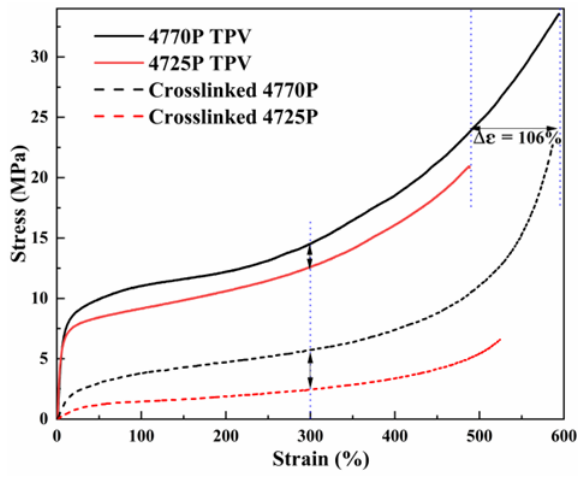
Figure 7. The stress-strain curves (up to break) of the crosslinked EPDMs and TPVs.